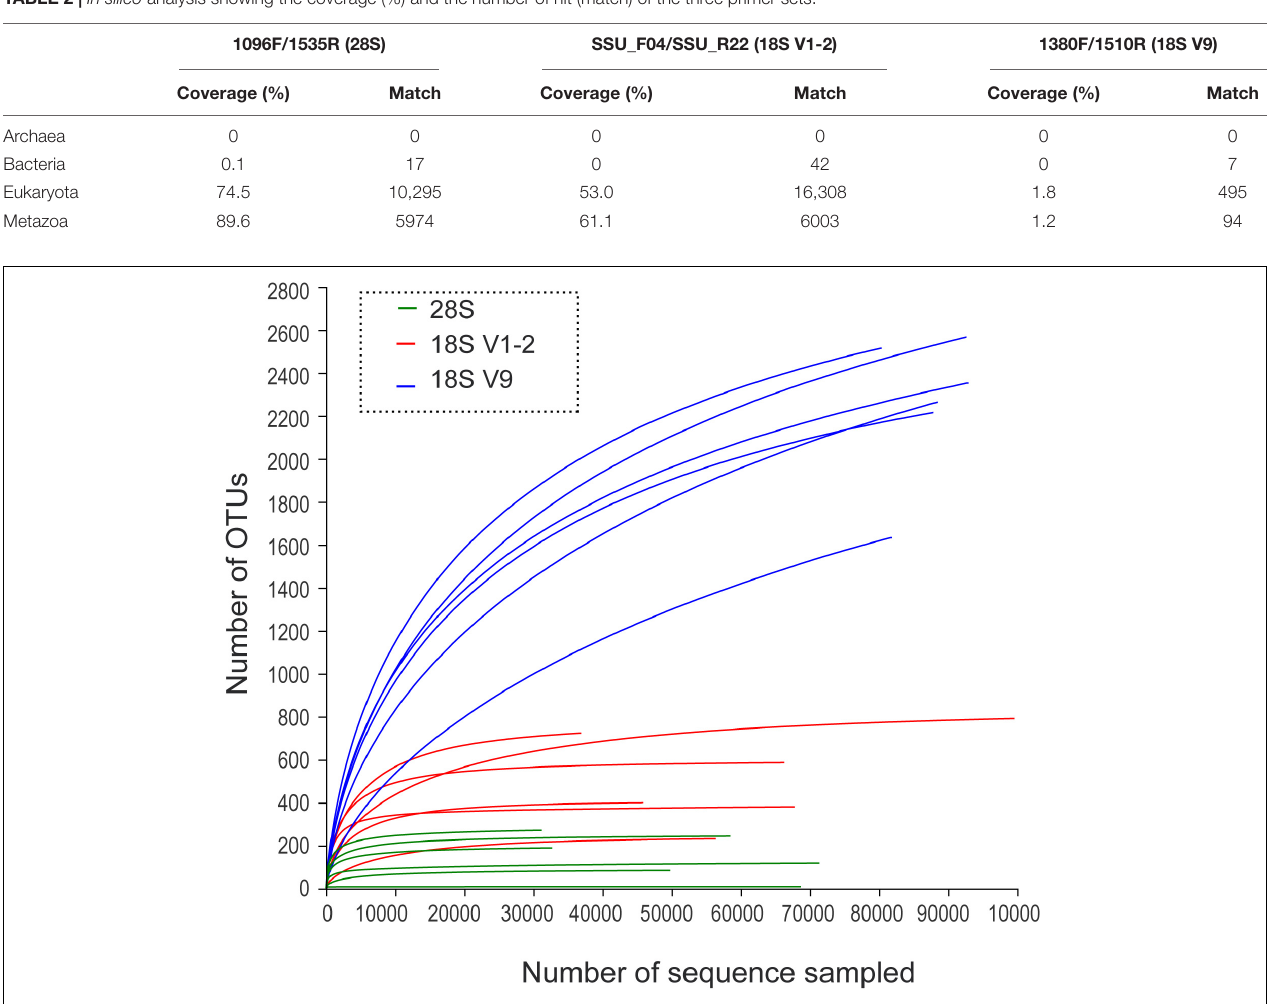
TABLE 2 | In silico analysis showing the coverage (%) and the number of hit (match) of the three primer sets.